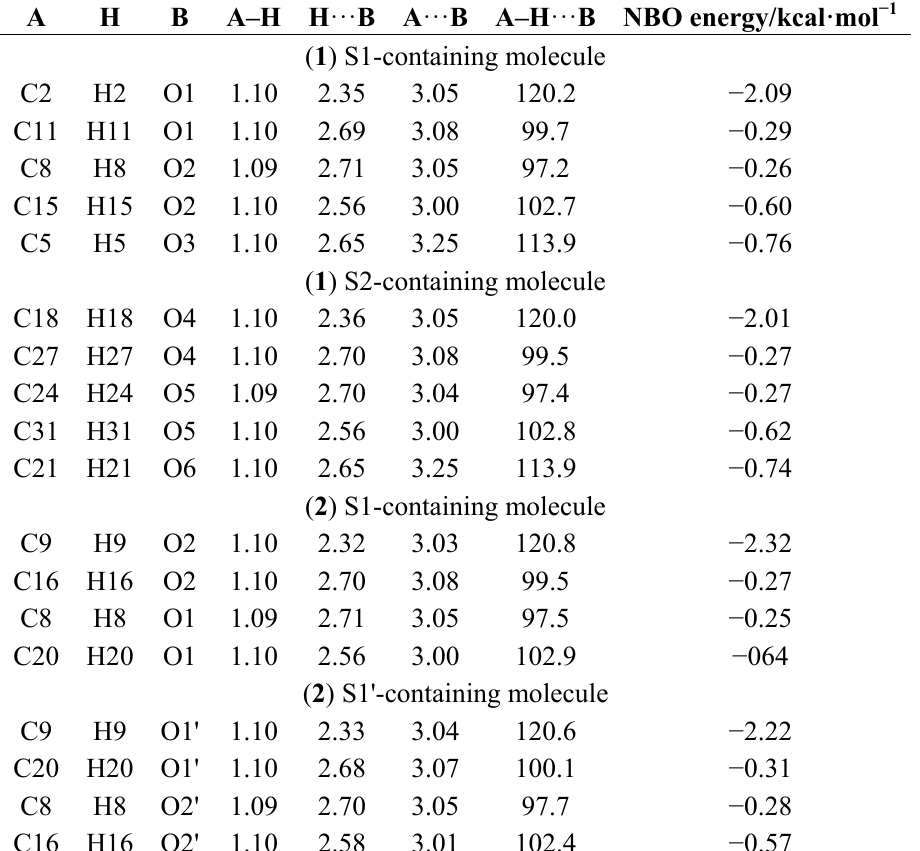
Table 2. Geometric parameters describing intramolecular interactions (A–H···B; Å, °) for ( 1 ) and ( 2